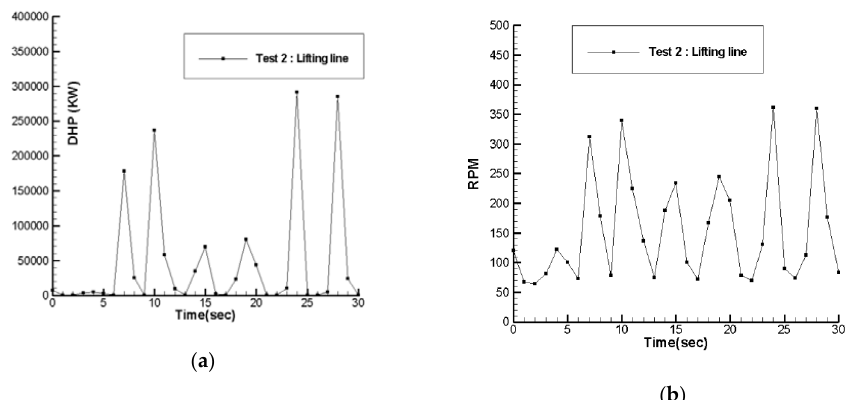
Figure 29. Time history of the required DHP ( a ) and RPM ( b ), numerical experiment #2.